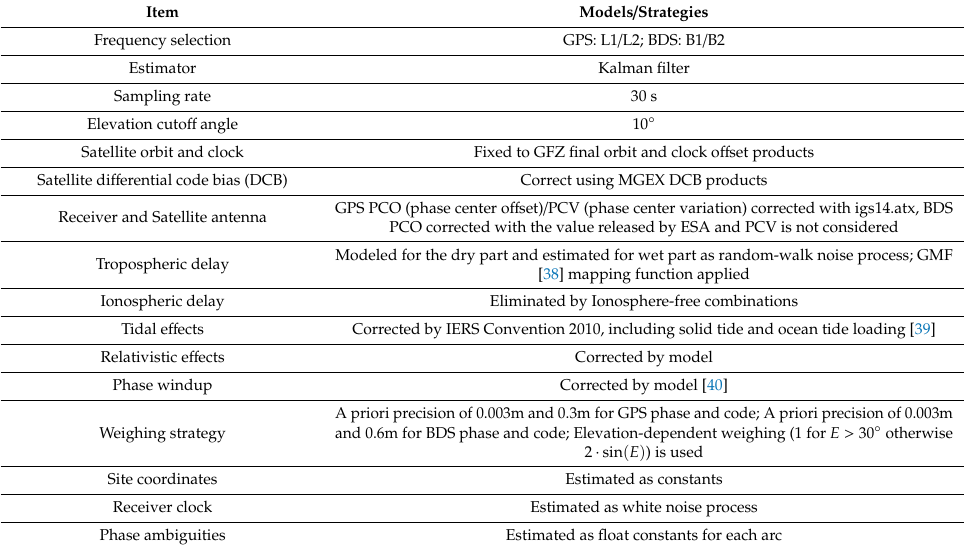
Table 3. Adopted models and strategies for multi-Global Navigation Satellite System (GNSS) static Precise Point Positioning (PPP).